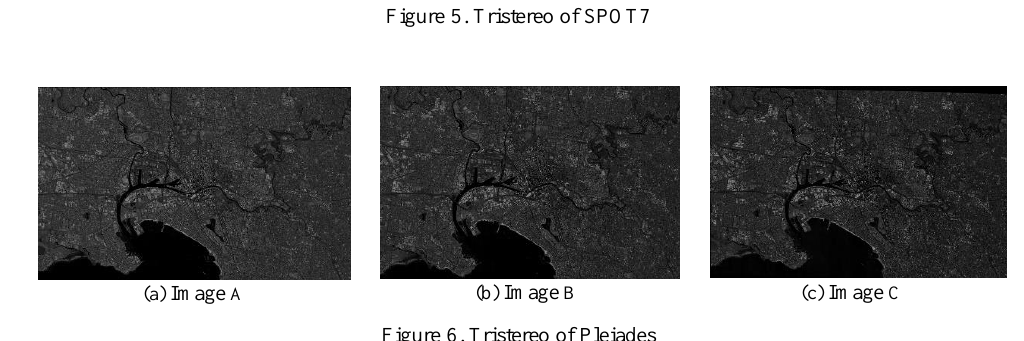
Figure 6. Tristereo of